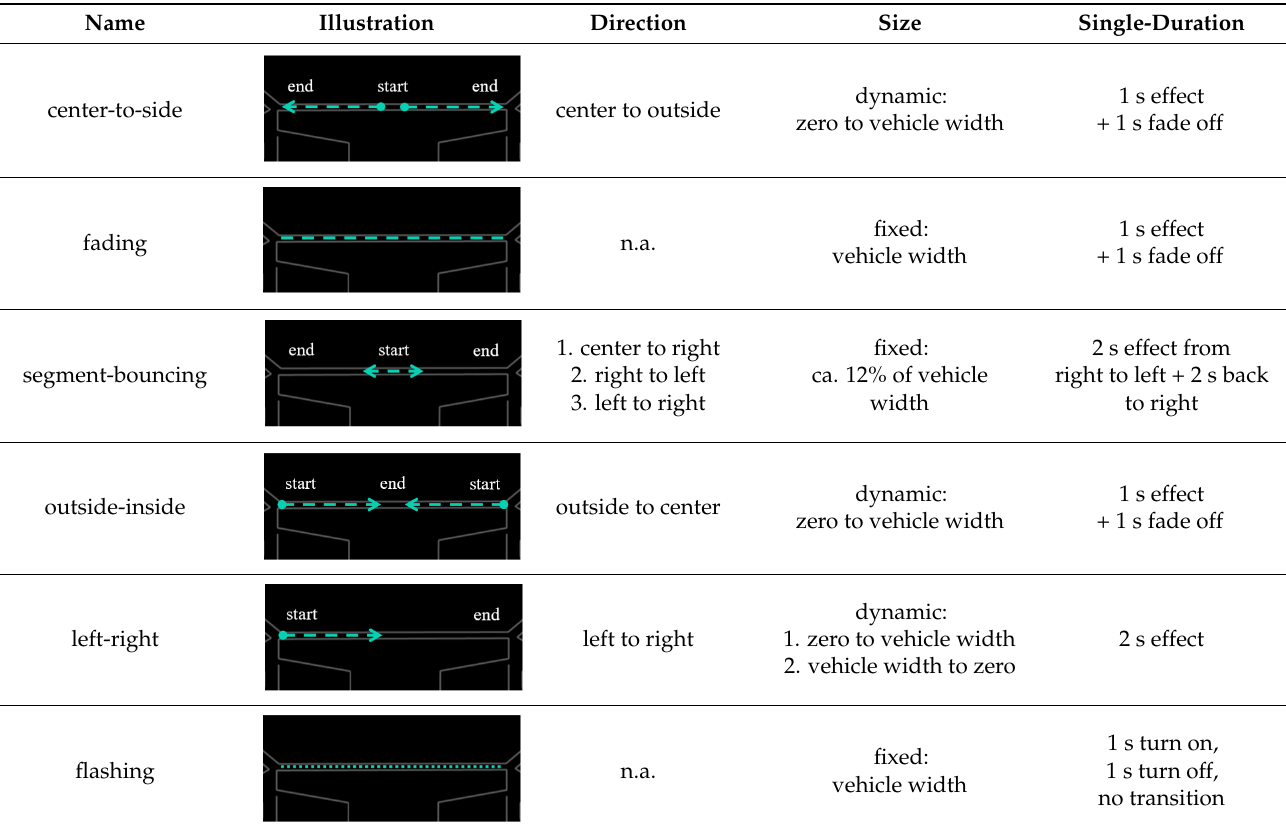
Table 9. Dynamic light pattern description used as short animation within the survey. Table 1. Dynamic light pattern description used as short animation within the survey. Table 1. Dynamic light pattern description used as short animation within the survey. Table 1. Dynamic light pattern description used as short animation within the survey. Table 1. Dynamic light pattern description used as short animation within the survey. Table 1. Dynamic light pattern description used as short animation within the survey. Table 1. Dynamic light pattern description used as short animation within the